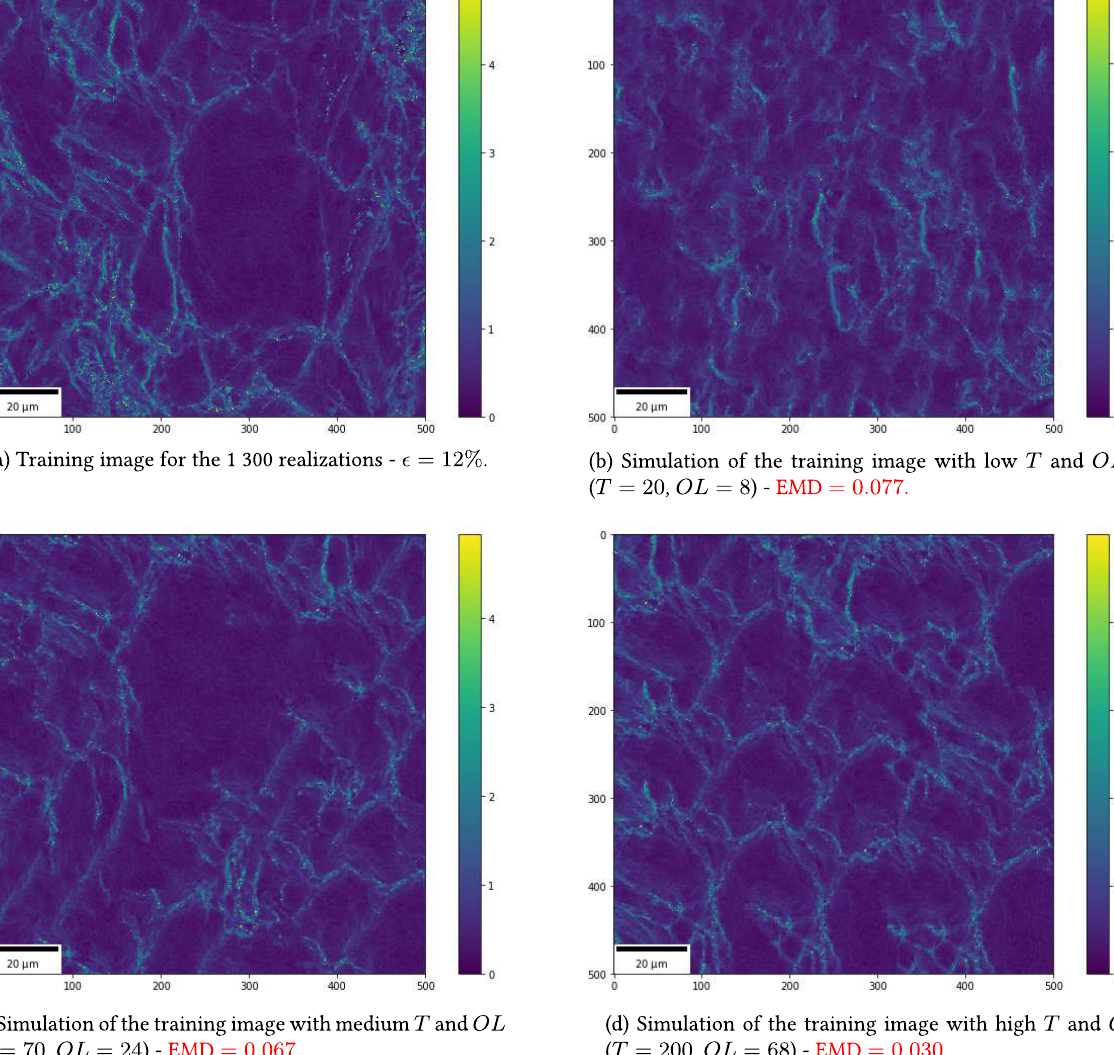
Fig. 11. Examples of impact of T and OL on simulations’ quality – ( T, OL ) ∈ { (20 , 8) , (70 , 24) , (200 , 68) }